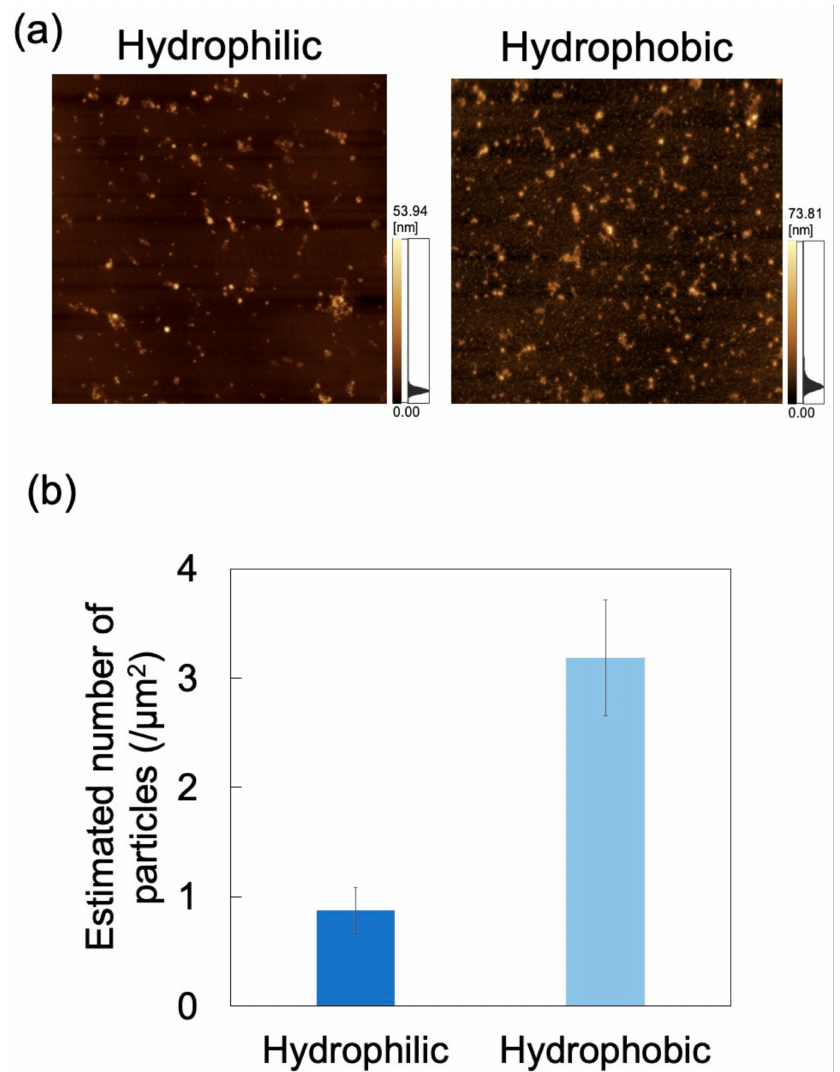
Figure 11. Adsorption of exosomes on hydrophilic and hydrophobic polydimethylsiloxane (PDMS)- based microchannels at pH 6 and 0.7 mL/h. ( a ) Atomic force microscopy images of PDMS-based microchannels with different wettability. Scan area = 8 µ m × 8 µ m. ( b ) Number of exosomes adsorbed on PDMS-based microchannels ( n = 5). Error bars represent the standard